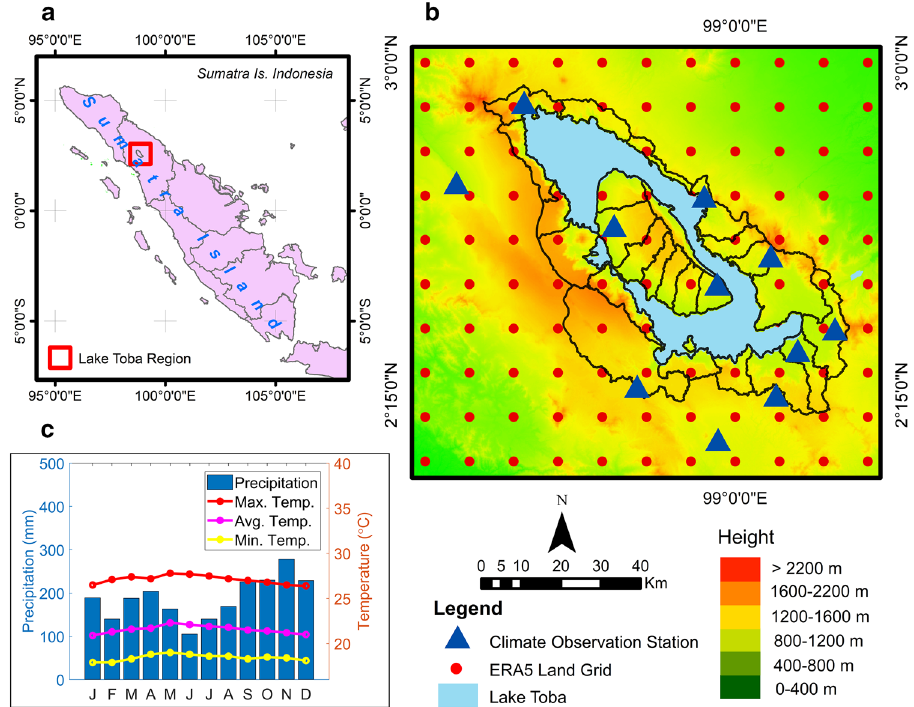
Figure 1. General description of the research area of the Lake Toba Region, ( a ) Located in the northern part of Sumatra Island, Indonesia, ( b ) Topography and Catchment Area of Lake Toba with Climate Observation Station, ( c ). Climagram of temperature and rainfall observation